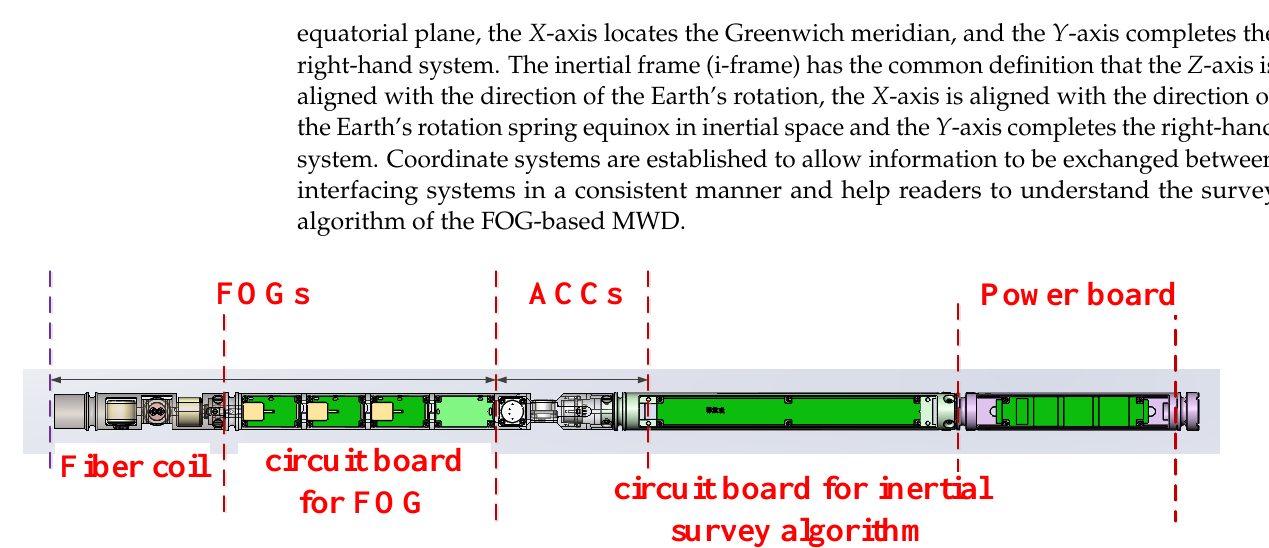
Figure 2. Flow chart of the FOG-based MWD measurement algorithm. Firstly, the carrier angular velocity b ib  is measured by the FOGs in b-frame. The carrier acceleration b ib f is measured by the ACCs in b-frame. Secondly, the errors in the original sensor data should be compensated. b ib  and b ib f